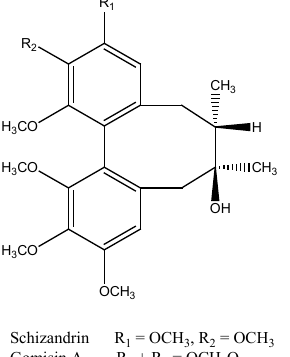
Figure 1. Structures of the active constituents isolated from S. chinensis.